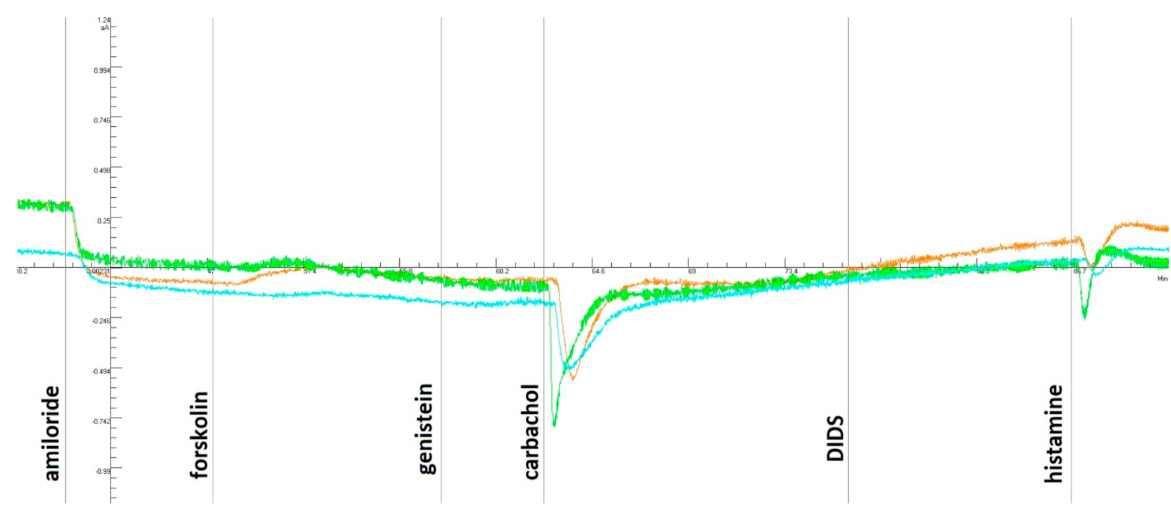
Figure 2. ICM measurements of the patient’s rectal biopsies while taking tezacaftor/ivacaftor and ivacaftor. With the introduction of amiloride, there was a decrease in the ∆ ISC and no response to forskolin/IBMX, and a change in the ∆ ISC in the negative direction was observed with the addition of carbachol and